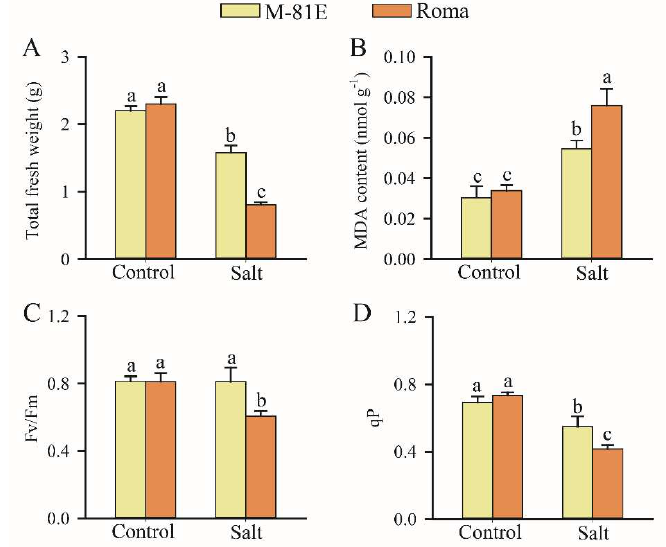
Figure 1. Effect of salt stress on total fresh weight ( A ), MDA content ( B ), the maximum quantum yield of PSII ( C ), and qP ( D ) of salt-tolerant (M-81E) and salt-sensitive (Roma) genotypes. Each value represents the mean of 6 replicates ± SD. Different letters indicate a significant difference ( p < 0.05) between the control and the treatment.